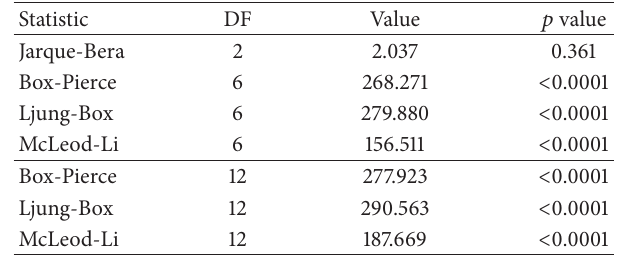
Table 3: Normality and white noise tests